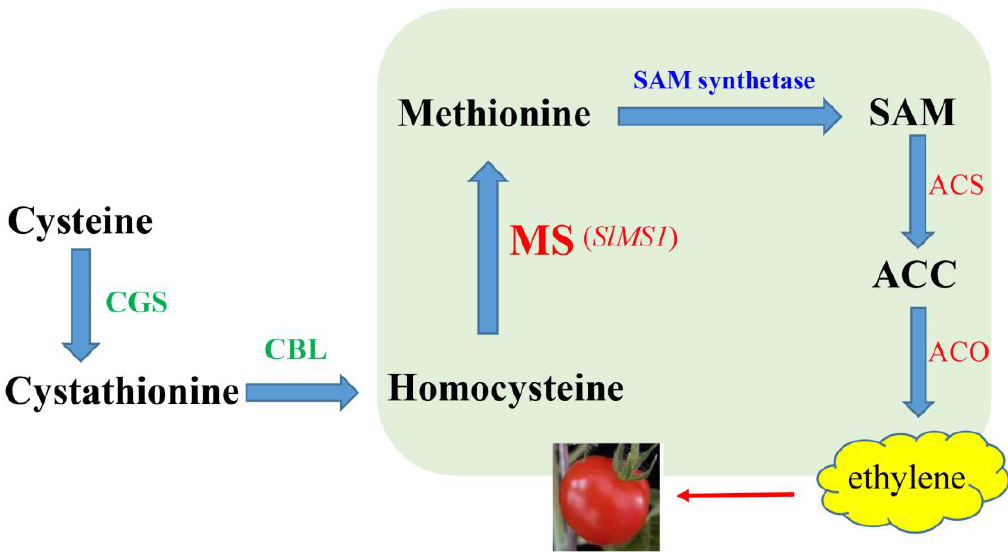
Figure 10. Metabolic diagram of methionine regulating fruit ripening. For methionine biosynthesis, CGS catalyzes the generation of cystathionine from cysteine and O-phosphohomoserine, and then, homocysteine is produced by CBL. The last step of Met synthesis is catalyzed by methionine syn- thase (MS encoded by SlMS1 ), which methylates homocysteine to form Met using N5-methyltetra- hydrofolate as a methyl group donor. Methionine generates methyl donor SAM under the action of S-adenosylmethionine synthase, and then, ACC synthase (ACS) and ACC oxidase (ACO) catalyze the biosynthesis of ethylene. MS, methionine synth ase; CBL, cystathionine β -lyase; CGS, cystathi- onine γ -synthase; SAM, S-adenosylmethionine; ACC, 1-aminocyclopropane-1-carboxylate.